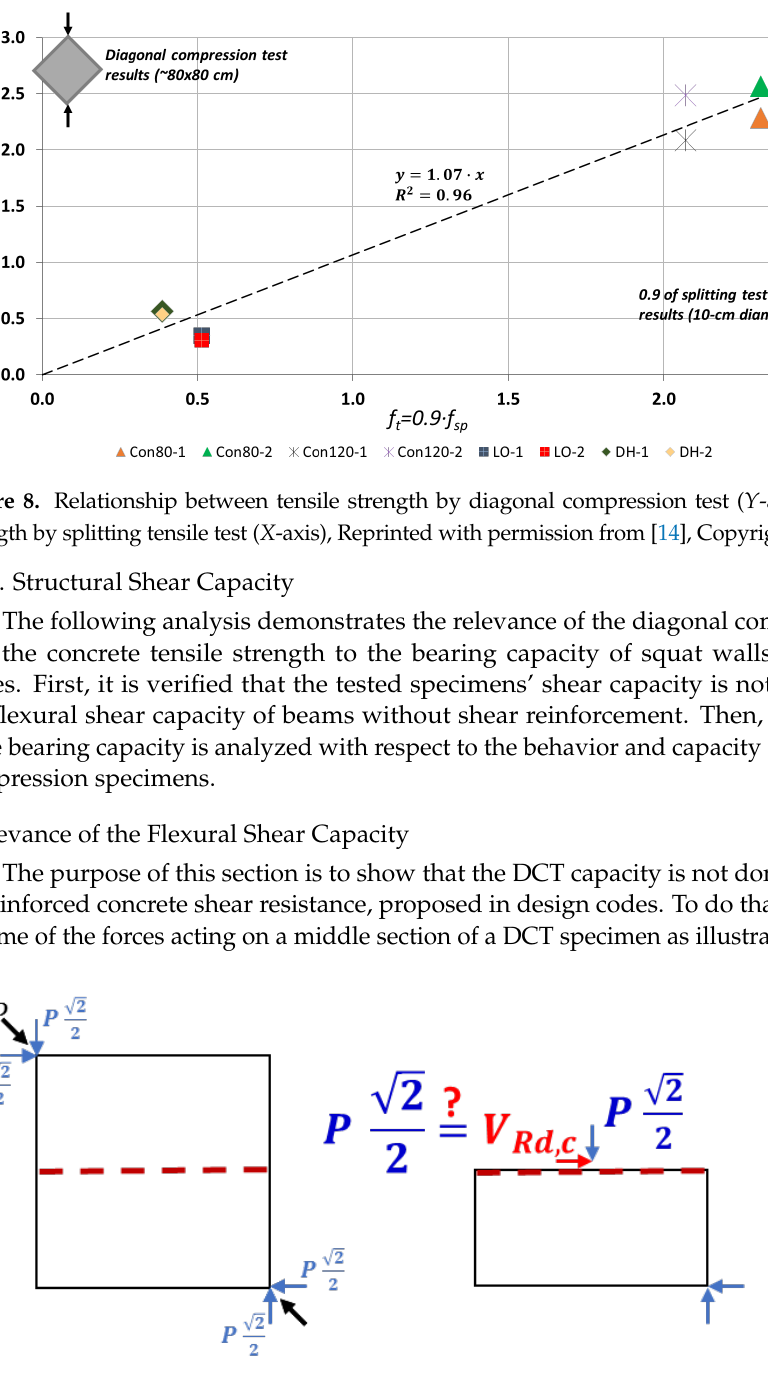
Figure 9. Scheme of the forces that act on a middle section of a diagonal compression specimen, Reprinted with permission from [14], Copyright 2021